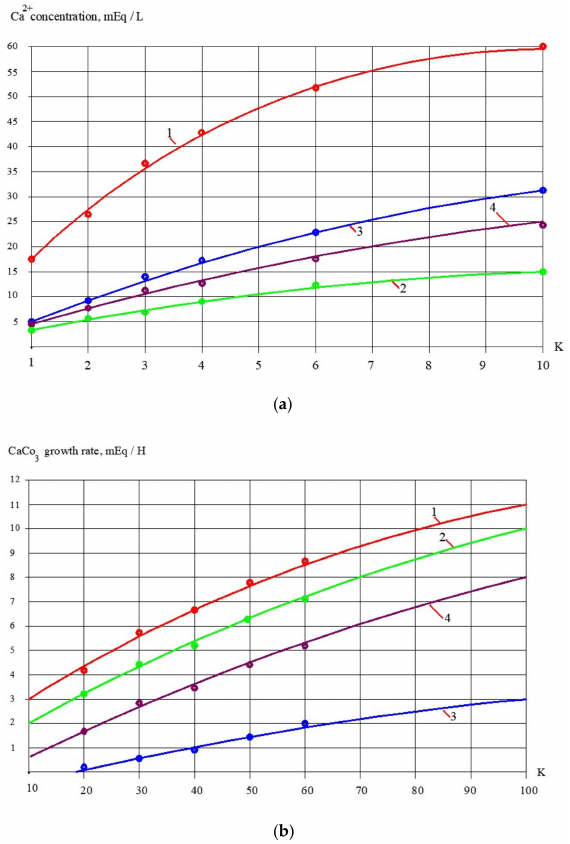
Figure 10. Results of calcium carbonate growth rate evaluations in the first series when natural water volume was reduced by 200 times: ( a ) dependencies of calcium concentration values on T during natural water concentration experiments; ( b ) dependencies of calcium carbonate growth Membranes 2023 , 13 , x FOR PEER REVIEW 14 of 18 rate values on K determined under different conditions: 1—concentrating of the feed water on the second step of the first experimental series (concentrating of the water concentrate previously concentrated by 10 times at the first step, using “Aminat-K”); 2—concentrating of the natural water into the water that is withdrawn with the dewatered sludge. Figure 11 shows dependen ‐ cies of the specific product flow of nanofiltration membrane on the first stage and of re ‐ by 10 times at the second step of the first experimental series using nanofiltration membrane, without verse osmosis membrane on the second stage on K. Dependencies of all ionic species con ‐ antiscalant addition; 3—concentrating of the natural feed water at the first step of the first series using tained in water and COD in concentrate (a) and product water (b) on K values for nano ‐ nanofiltration membrane, “Aminat-K” dosing, 3 ppm; 4—concentrating of feed water by 10 times at filtration and reverse osmosis membranes, respectively, are presented in Figures 12 and 13. the second stage using reverse osmosis membrane, “Aminat-K” dosing, 3 ppm.